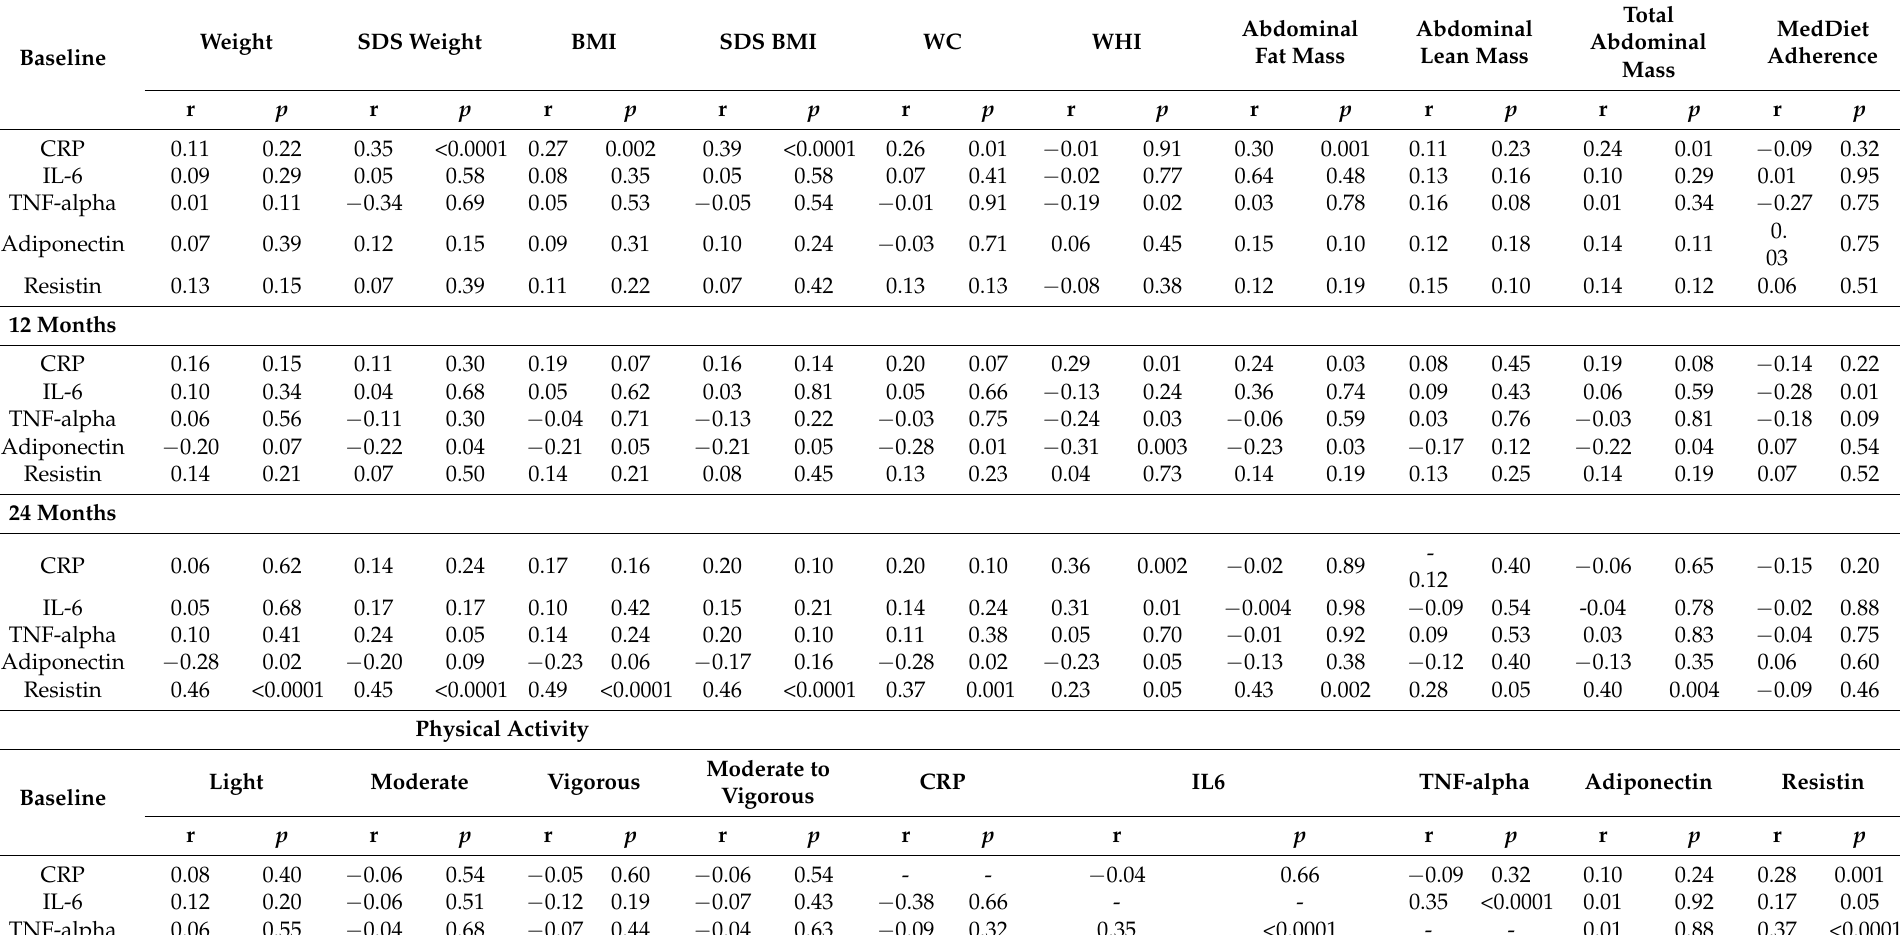
Table 7. Pearson correlation’s coefficient: inflammatory biomarkers and adipokines vs. anthropometric parameters, Mediterranean Diet adherence and physical activity levels of intensity at baseline, after 12 months and after 24 months of intervention. m: months, BMI: body mass index, WC: waist circumference, WHI: waist/hip index, MedDiet: Mediterranean